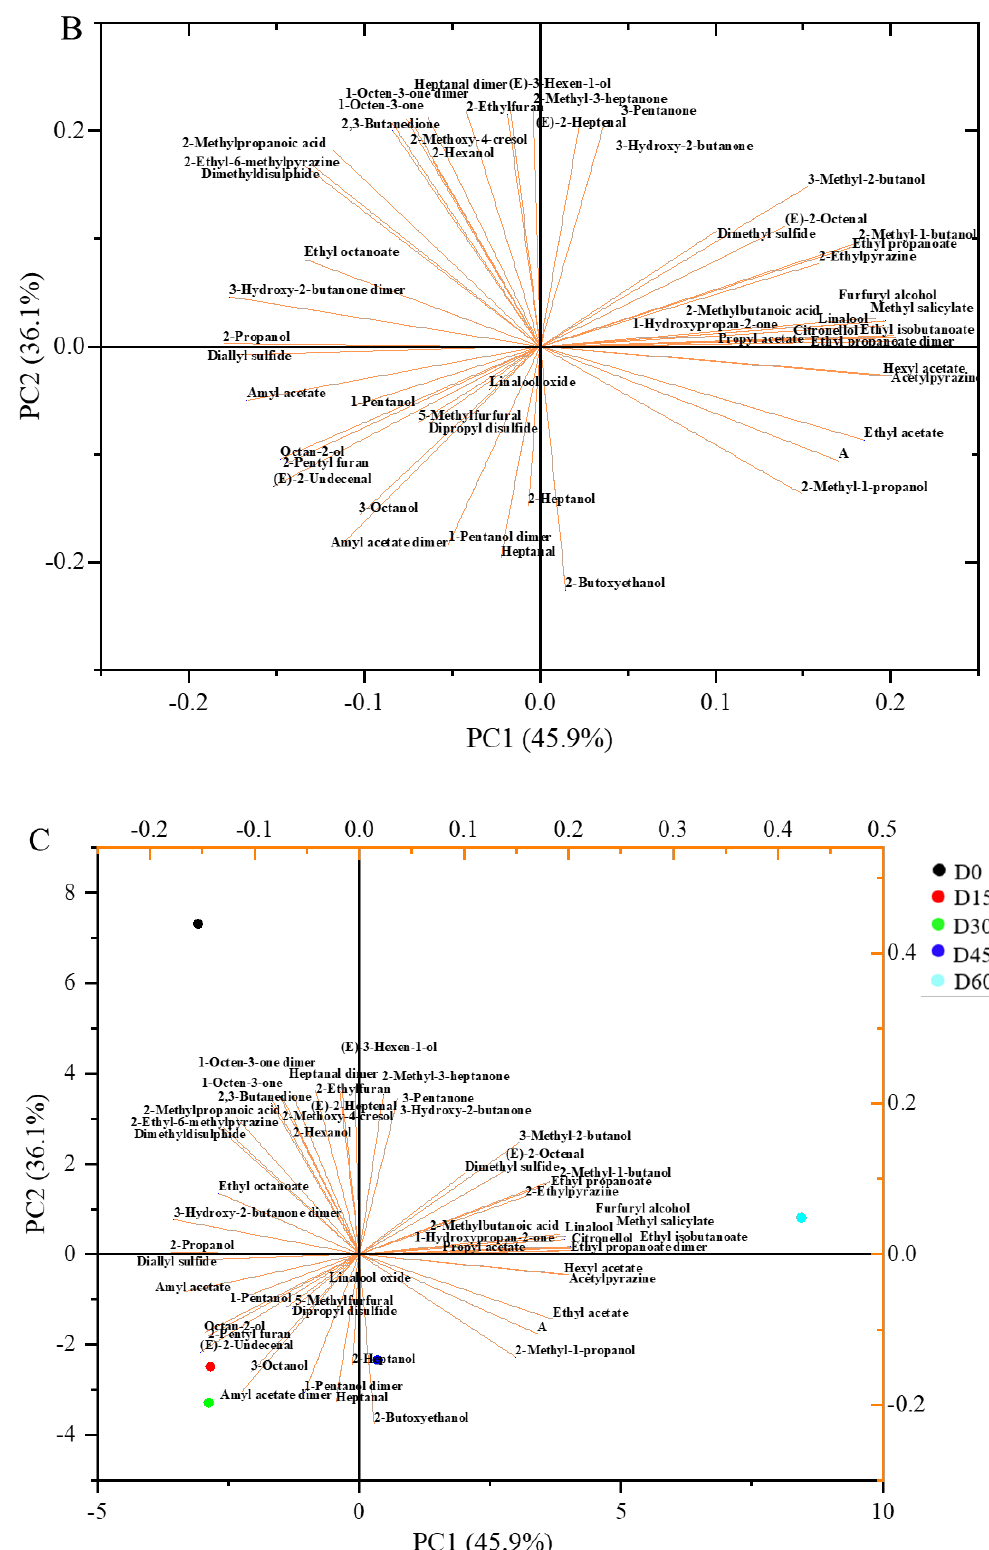
Figure 6. PCA analysis of Dongzao. ( A ) score plot of the first two principal components, D0, D15, D30, D45, and D60 represent refrigeration for 0, 15, 30, 45, and 60 days, respectively. ( B ) loading plot of different variances, ( C ) biplot of PCA.